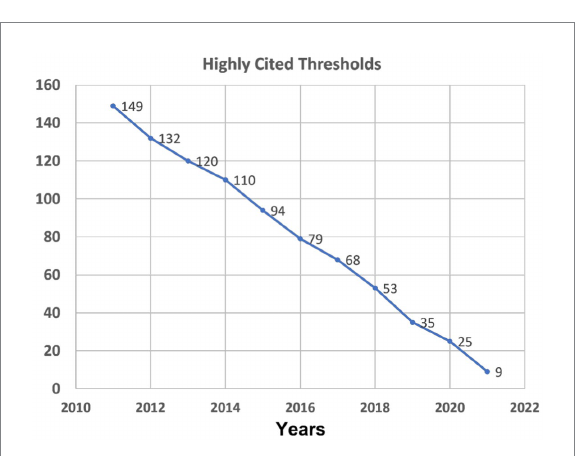
FIGURE 1 Highly cited thresholds in the research field of Social Sciences,